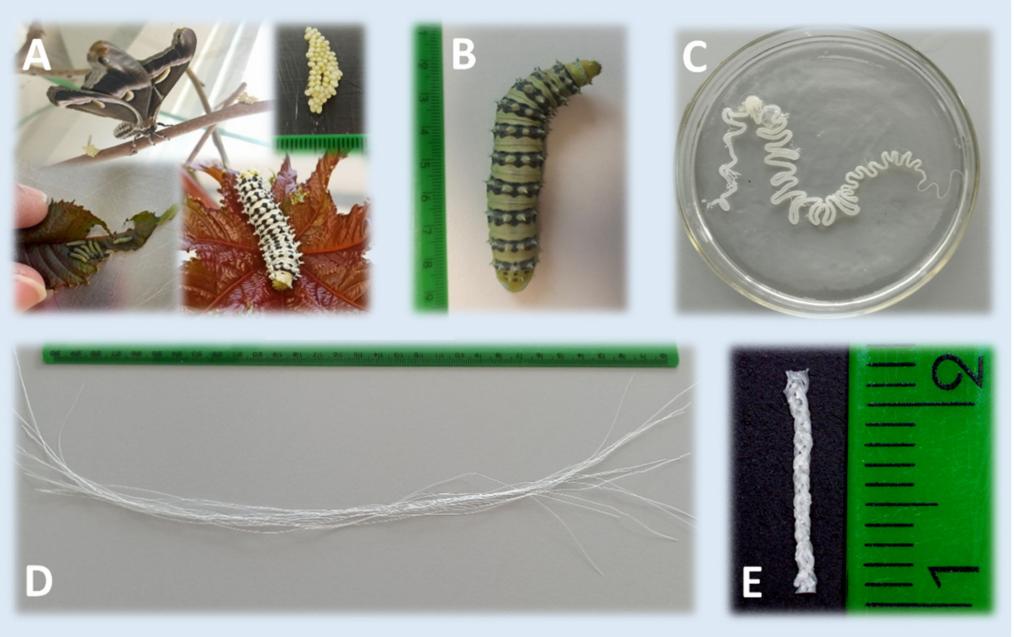
Figure 7. Illustrative images of the rearing of S. c. ricini at different stages of development ( A ), the appearance of the mature worm ( B ), the silk gland in acetic acid ( C ), a macroscopic view of the